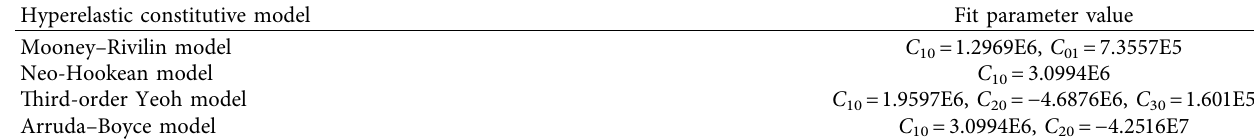
Table 1: Fitting parameters of each hyperelastic constitutive model for shore 70A.